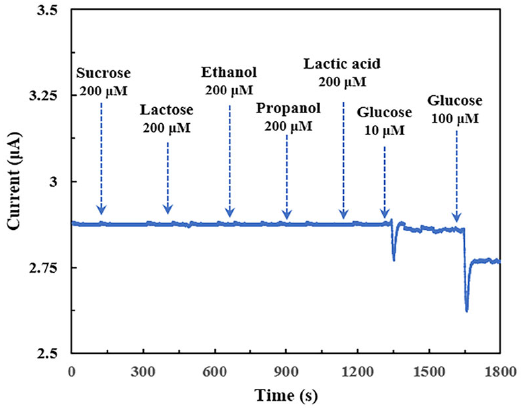
Figure 6. Anti-interference ability of NF/GDH/IL/mPEG-fMWCNTs/GCE in 50 mM pH 7 PBS at 25 ± 1 °C.